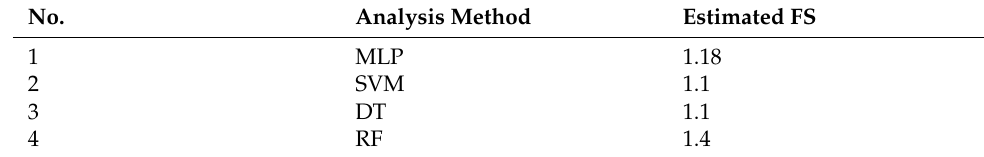
Table 6. The geotechnical information used for the example stability analysis. Table 7. FS evaluation by different models for the selected slope.